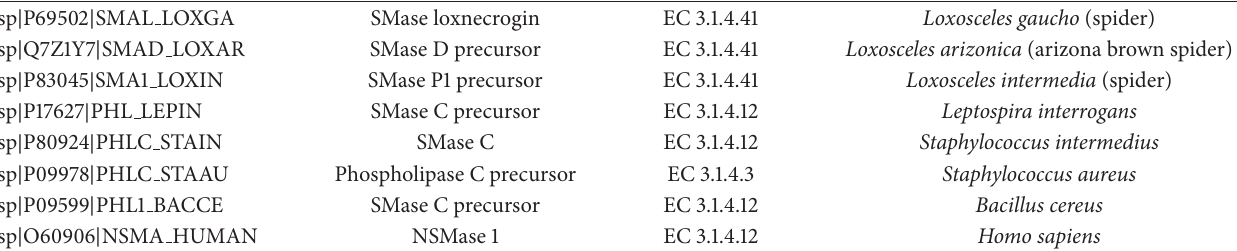
Table 1: SMase reference